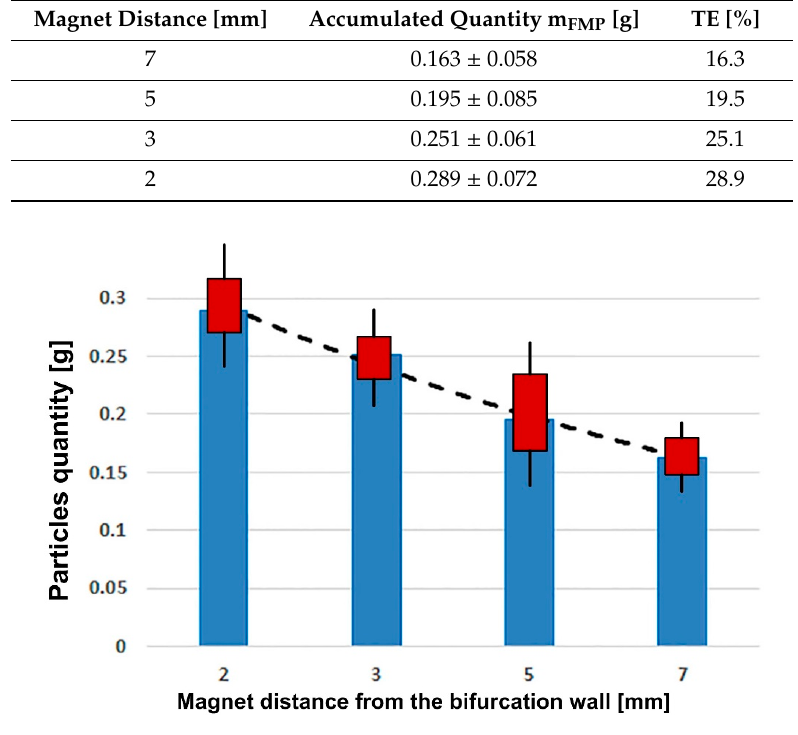
Figure 15. Particle accumulation efficiency in the targeted regions. Deposition trendlines are also represented.